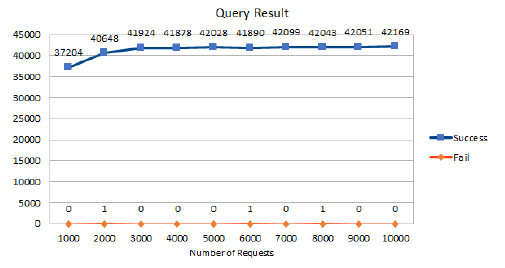
Figure 5. The results of the request data functions.